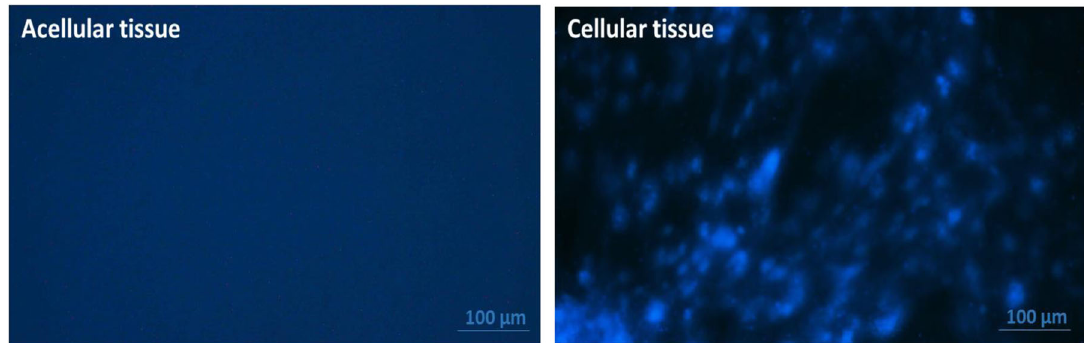
Fig. 1 DAPI staining of the thoracic aorta tissues. DAPI fl uorescent staining of the cellular and acellular aorta. The obtained images con fi rmed the absence of nuclei in the prepared acellular aorta matrices. Scale bar: 100